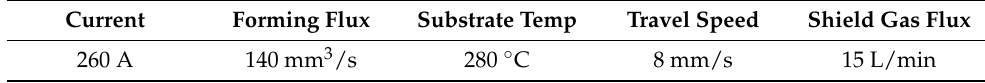
Figure 3. Good Al-2024 single-pass deposited layer. ( a ) Cross-section of deposited layer; ( b ) Partial enlargement of deposited layer; ( c ) Deposited layer with good morphology. Table 2. Standard baseline process parameters.